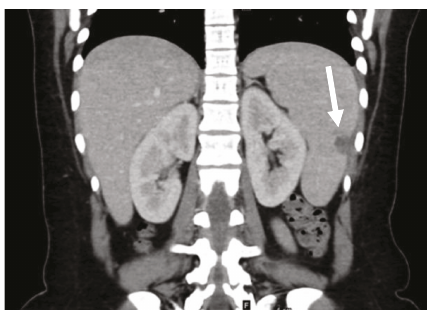
Figure 4: Follow-up CT scan shows hepatosplenomegaly with interval improvement regarding the splenic infarction.